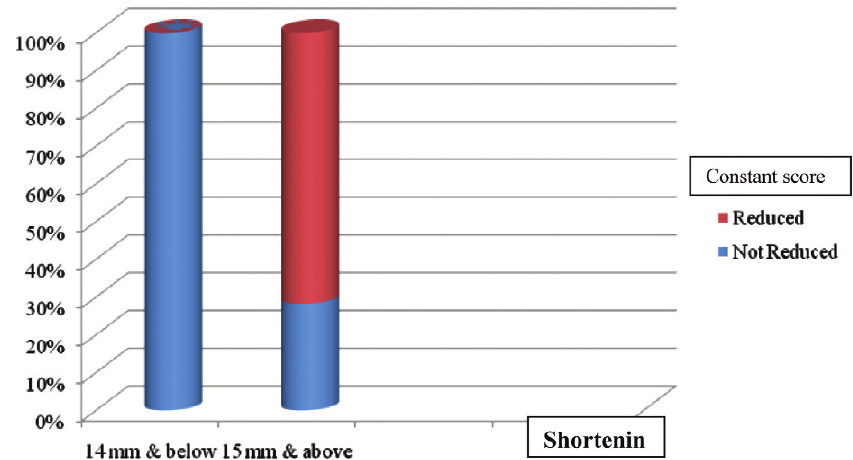
Figure 4 - Clavicle fracture shortening and Constant score.